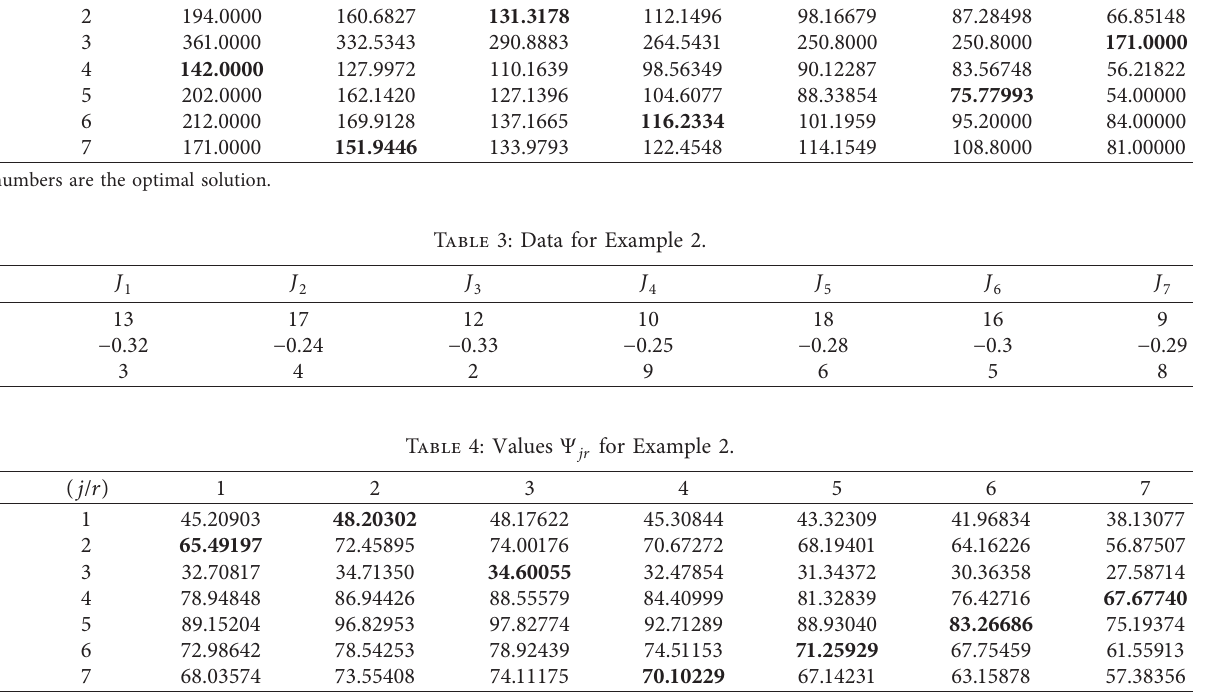
Table 2: Values Ψ